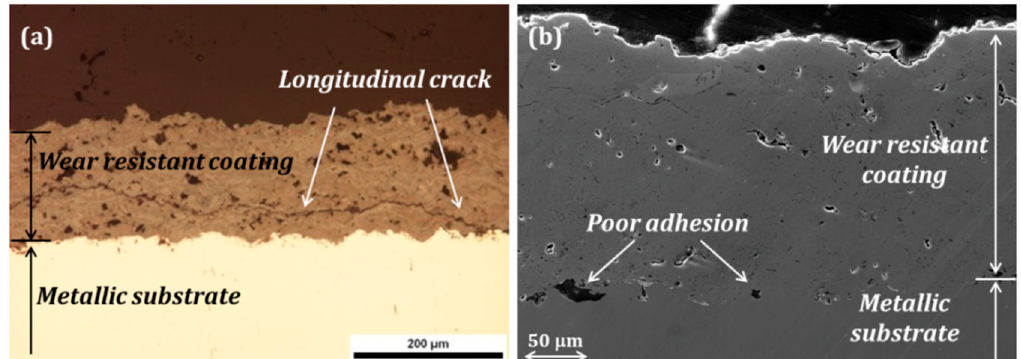
Figure 16. Microstructure flaws developed during plasma spray deposition of ( a ) a titania coating (optical micrograph), where a longitudinal crack propagated parallel to the coating/substrate interface and ( b ) a WC-Co coating (SEM micrograph) of poor adhesion to the metallic substrate, due to the presence of residues of the pre-deposition sandblasting preparation of the metallic surface.